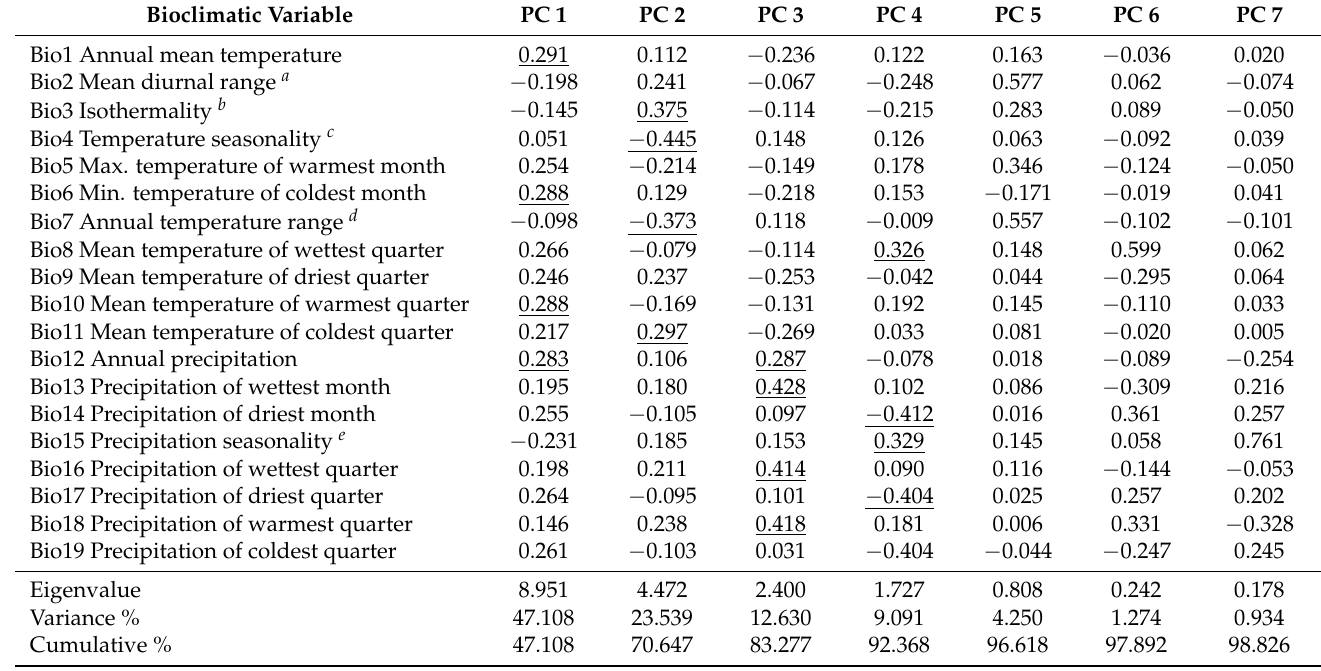
Table 2. The factor loadings of the first seven principal components concerning the 19 bioclimatic variables. Bioclimatic